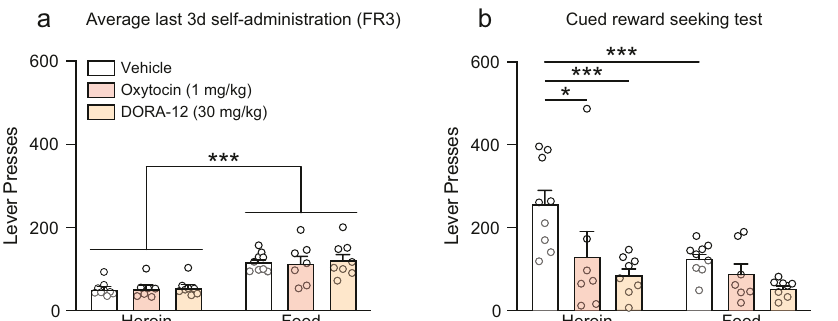
Fig. 4 Oxytocin and DORA-12 reduce drug seeking triggered by heroin cues. Responding did not differ between treatment groups during the FR3 sessions preceding the cued reward seeking test ( a ). Under conditions where both heroin and food cues are available, rats seek heroin at higher rates than food ( b ). Oxytocin (1 mg/kg) and DORA-12 (30 mg/kg) reduced heroin seeking, but not food seeking, in the presence of both heroin and food cues. * p < 0.05, *** p < 0.001 versus heroin-vehicle group (Two-way RM ANOVA followed by Sidak post hoc test). Data are shown as mean ±